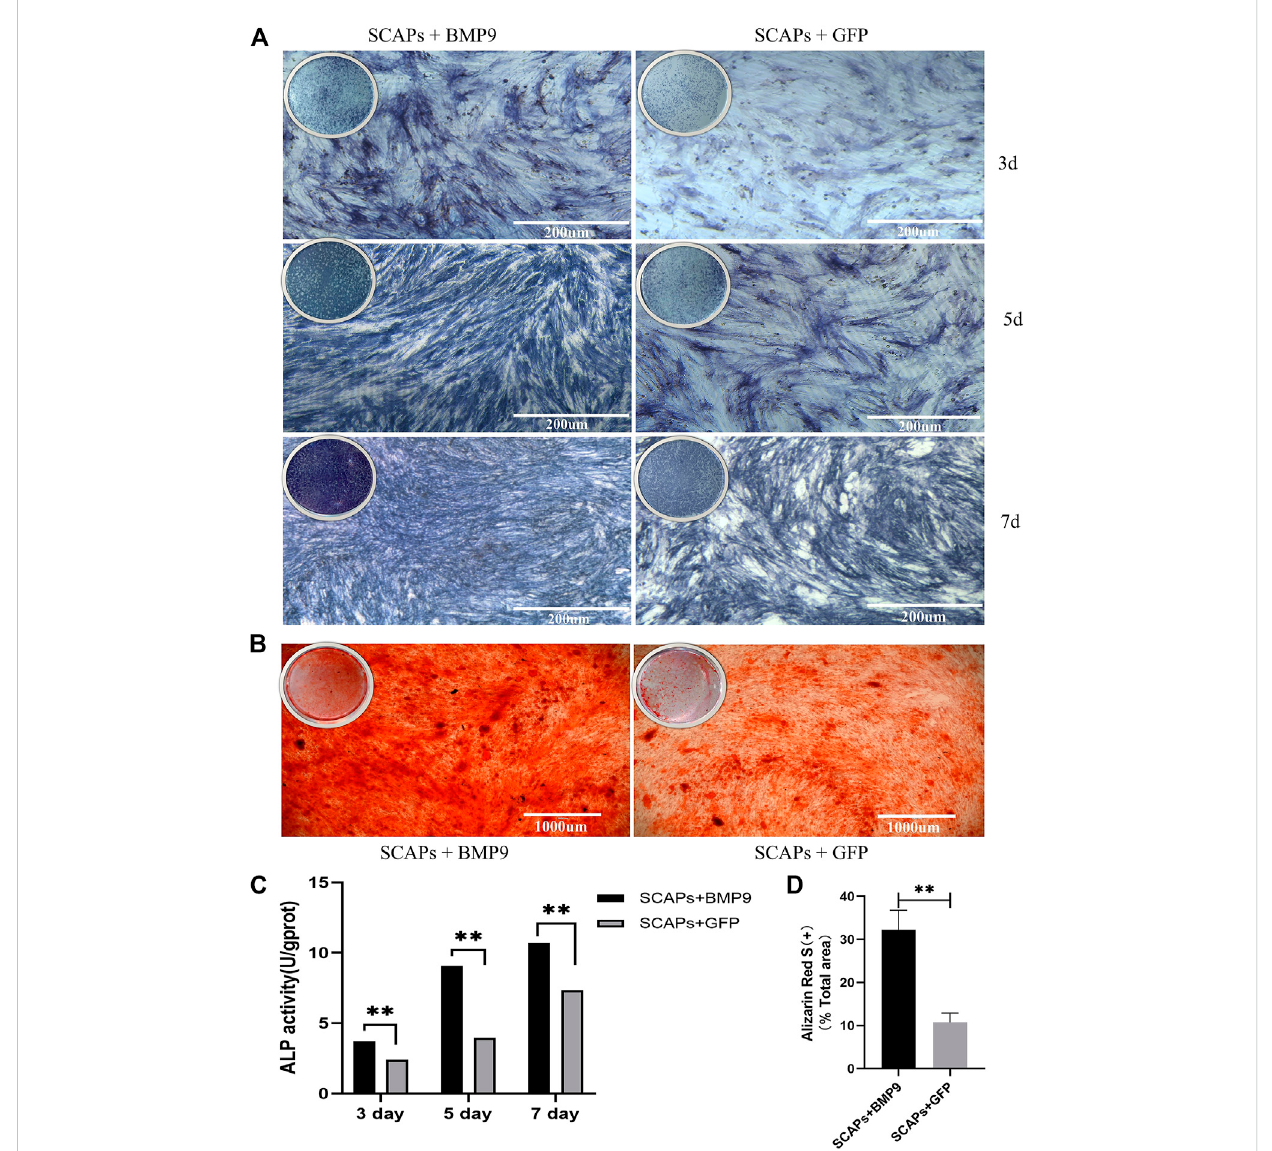
FIGURE 5 (A) ALP staining of SCAPs + BMP9 group and SCAPs + GFP group after 3,5,7 days of osteogenic induction (B) Alizarin red S staining indicated the formation of mineralised nodules after 21 days of osteogenic induction (C) ALPase activity results showed the upregulation of ALP in both groups (* p